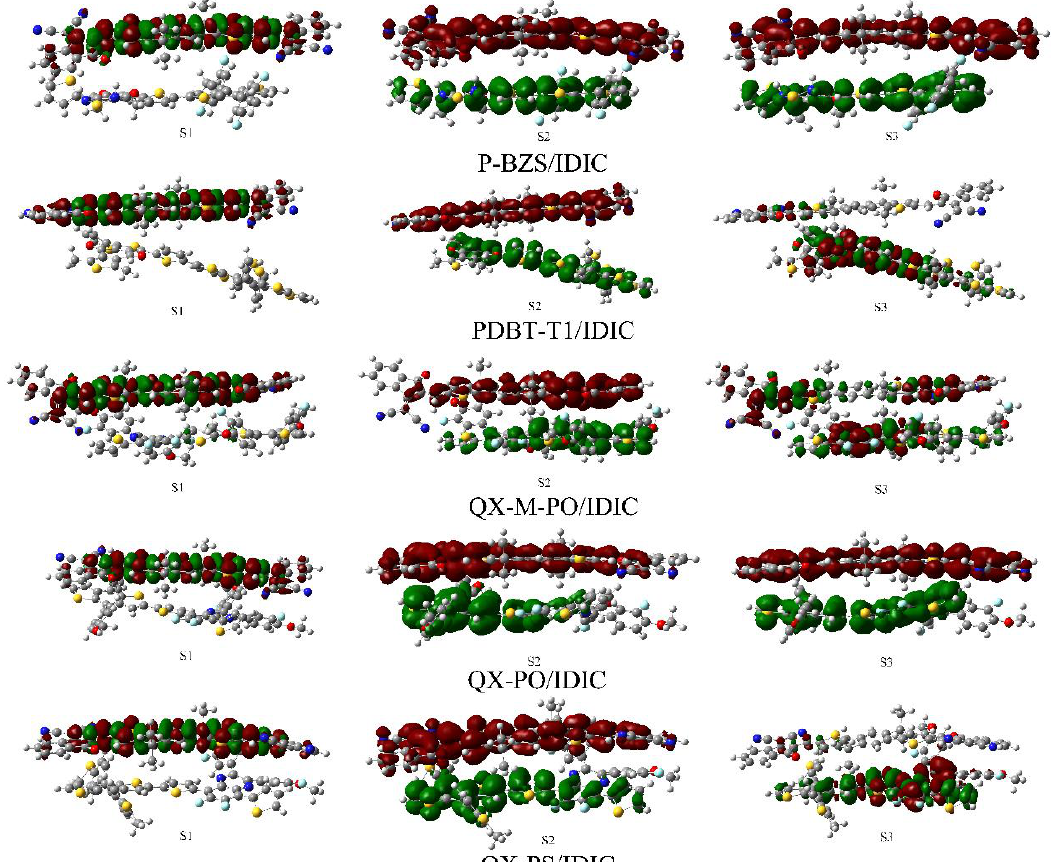
Figure 11. Charge difference densities (CDD) plots of polymer/IDIC interfaces (S1–S3), where red represents electrons and green represents holes.